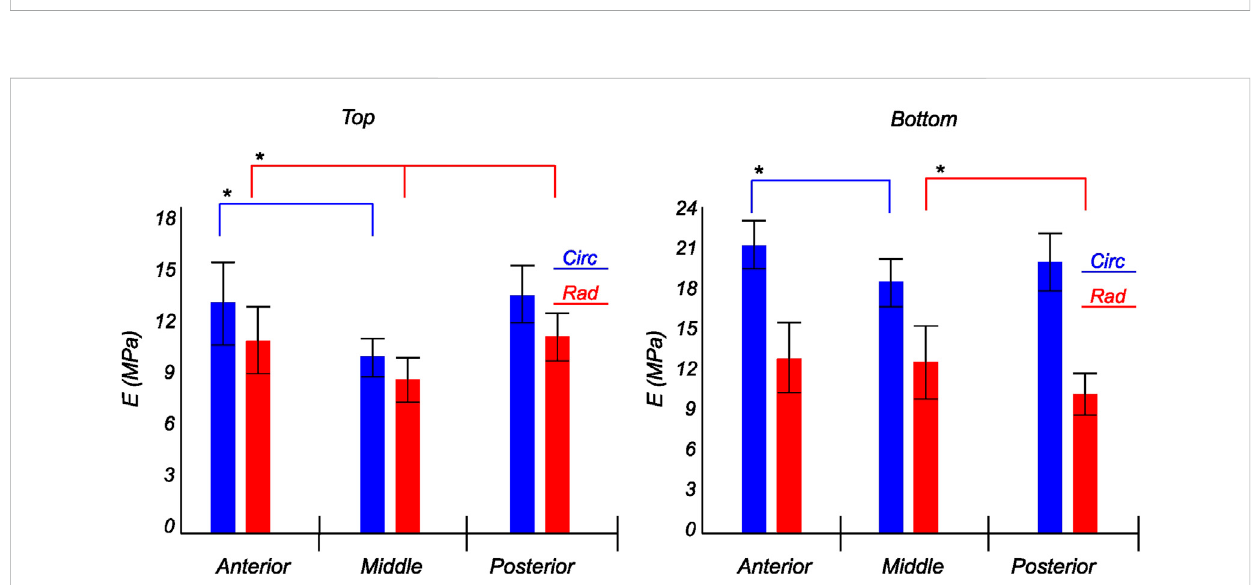
FIGURE 11 Computedelasticmodulusofahumanmedialmeniscusinthe fi nalloadingregime:toplayer(left),andbottomlayer(right).Theanisotropicnatureof the material is shown with the circumferential stiffness represented in blue and the radial stiffness represented in red. Within each layer, the anterior, middle, and posterior regions are presented to see the regional variations. * indicates statistical signi fi cance from a one-way ANOVA test with p -value <